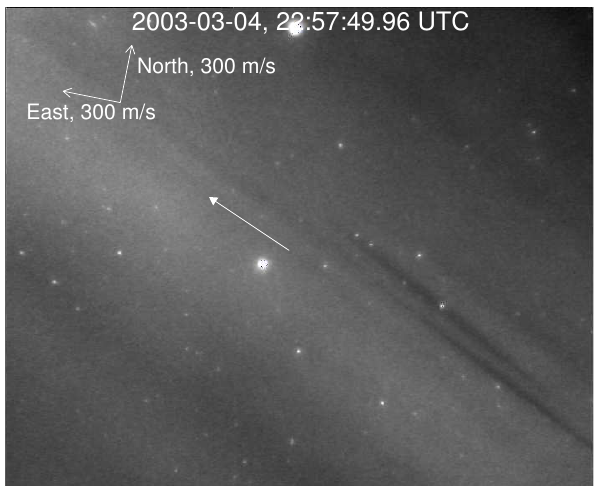
Fig. 5. An image from event 03D, where elongated black patches were drifting rapidly and parallel to the plasma flow (indicated by the vector).